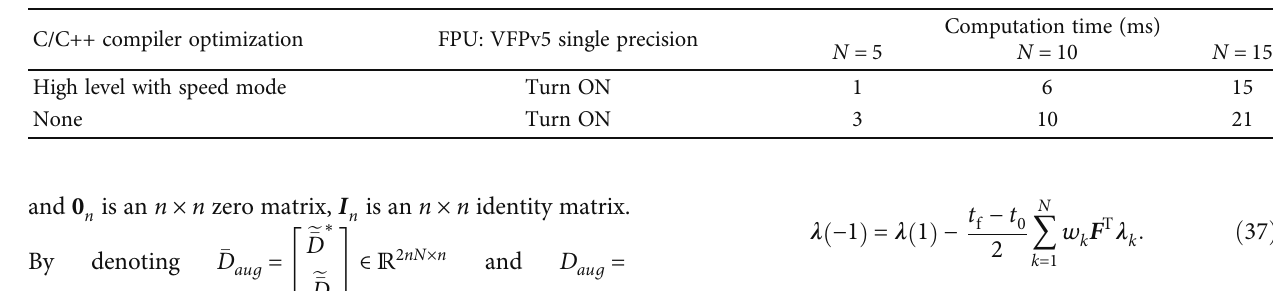
Figure 2: Hardware experiment setup. Table 2: Computation time of the proposed guidance